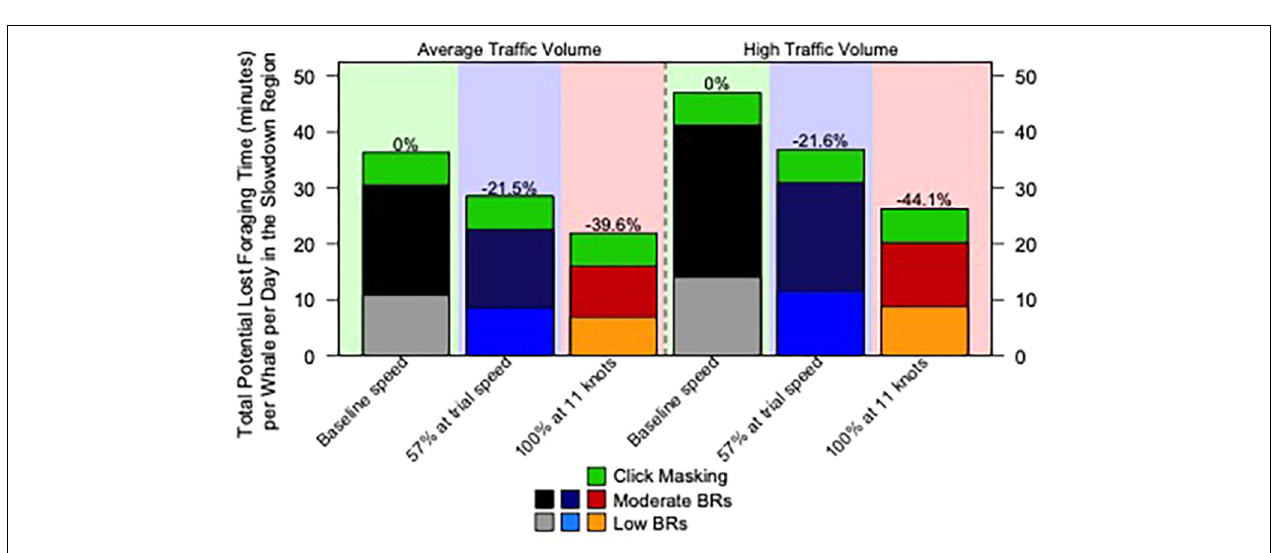
FIGURE 9 | Cumulative ‘Potential Lost Foraging Time’ for each of the six Vessel Speed and Traffic Scenarios (Scenarios 1 through 6, Table 2 ). Bars are stacked by the number of lost minutes for each of Low BR, Mod BR, and Click Masking. ‘Potential Lost Foraging Time’ is determined using the SRKW noise-exposure simulation model. Average and High Traffic Volume Scenarios corresponds to descriptions in Table 2